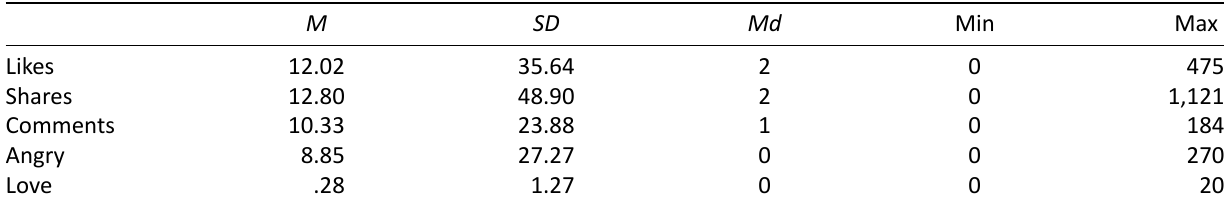
Table 5. Aggregated user